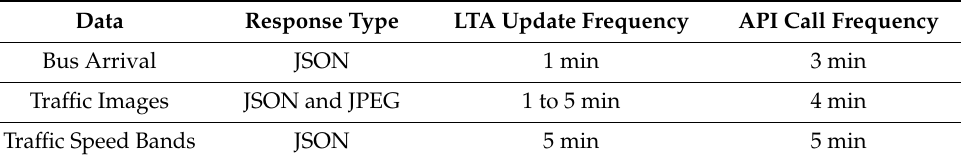
Table 6. Sources of real-time data and API call